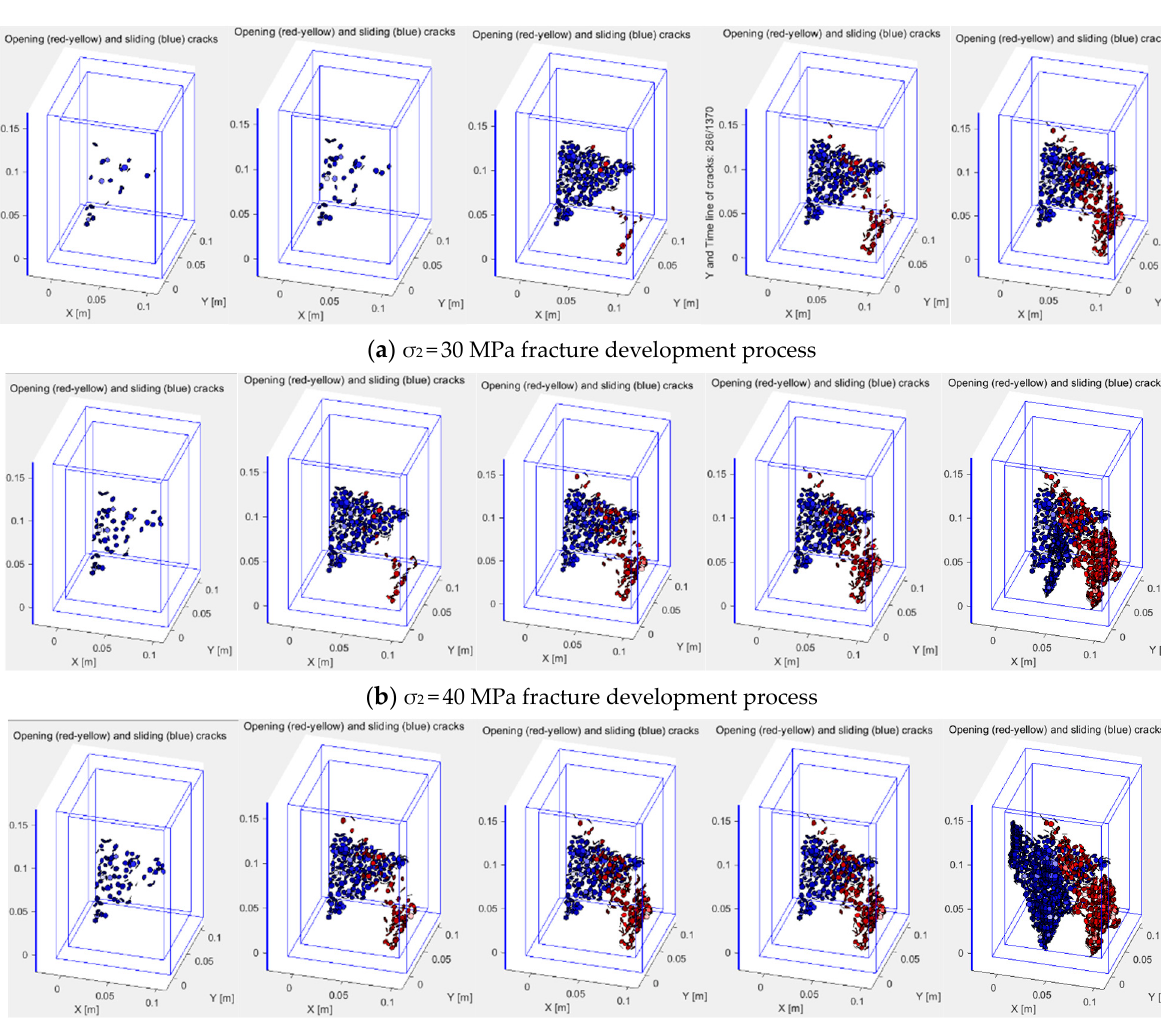
Figure 7. Fracture development characteristics under different intermediate principal stresses.